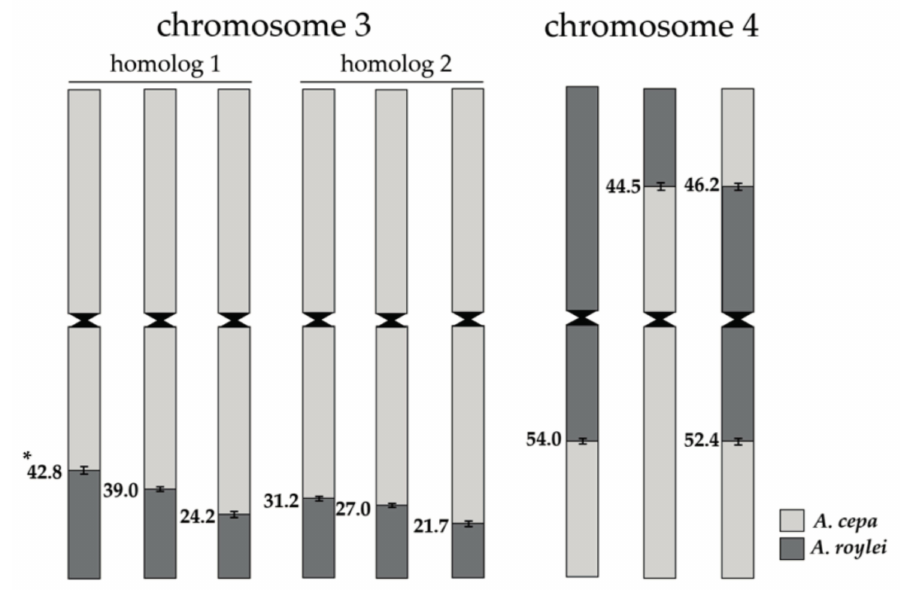
Figure 3. Types of recombinant chromosomes in S 2 BC 2 offspring. * Position of recombination site is the ratio of the length of the distance between distal end of chromosome arm and recombination site to the total length of the arm